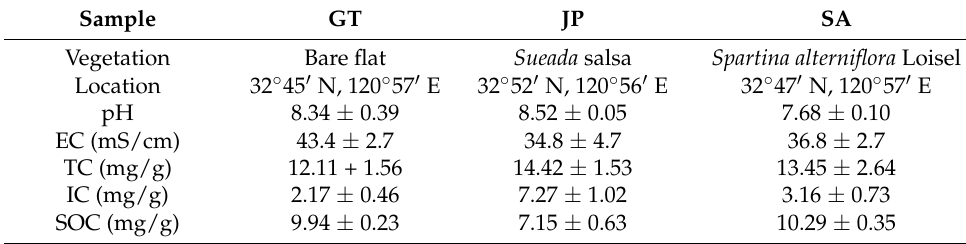
Table 1. Sample collection area information and partial physicochemical properties information.